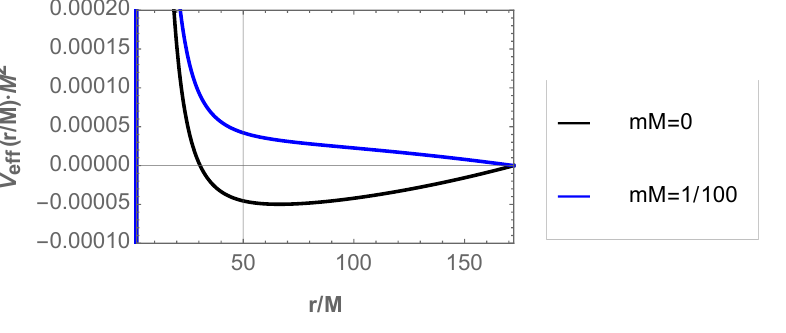
Figure 5 . The effective potential V eff ( r/M ) M 2 as a function of r/M , with Λ M 2 = 1 / 10000 , Q/M = 0 . 50 , qM = 0 . 1 , and ‘ = 0 . Here, ω 2 M 2 = 9 ∗ 10 − 8 , and V eff ( r Λ /M ) M 2 ≈ 9 ∗ 10 − 8 . Here r H /M ≈ 1 . 866 , and r Λ /M ≈ 172 . 197